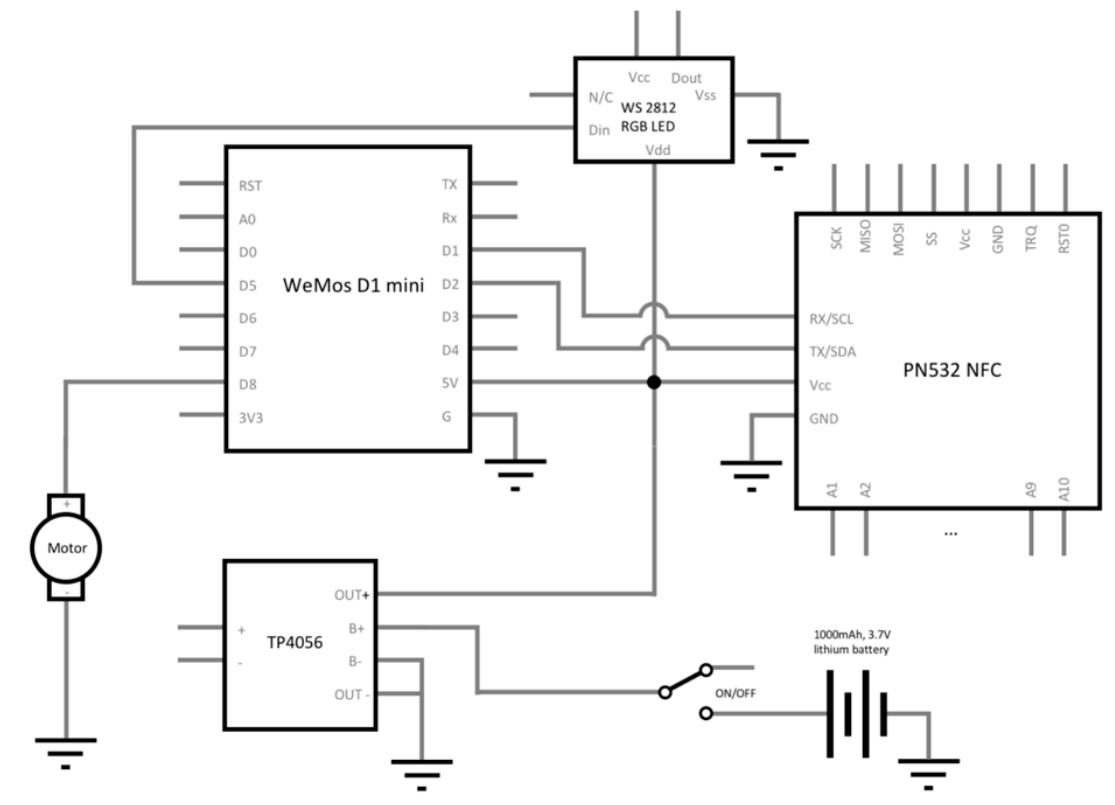
Figure 9. MovED electronic component connections.